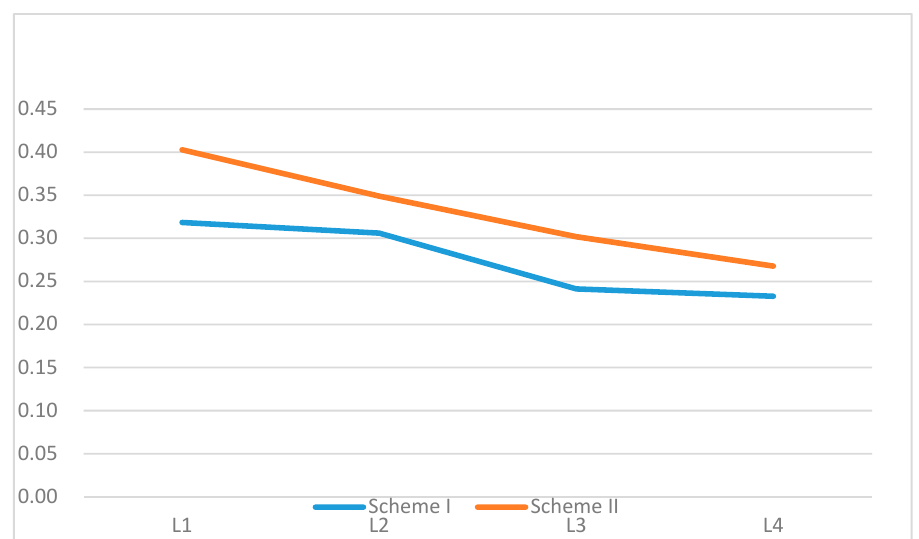
Figure 8. Comparison of the results of comprehensive benefit evaluation based on different project stakeholders.